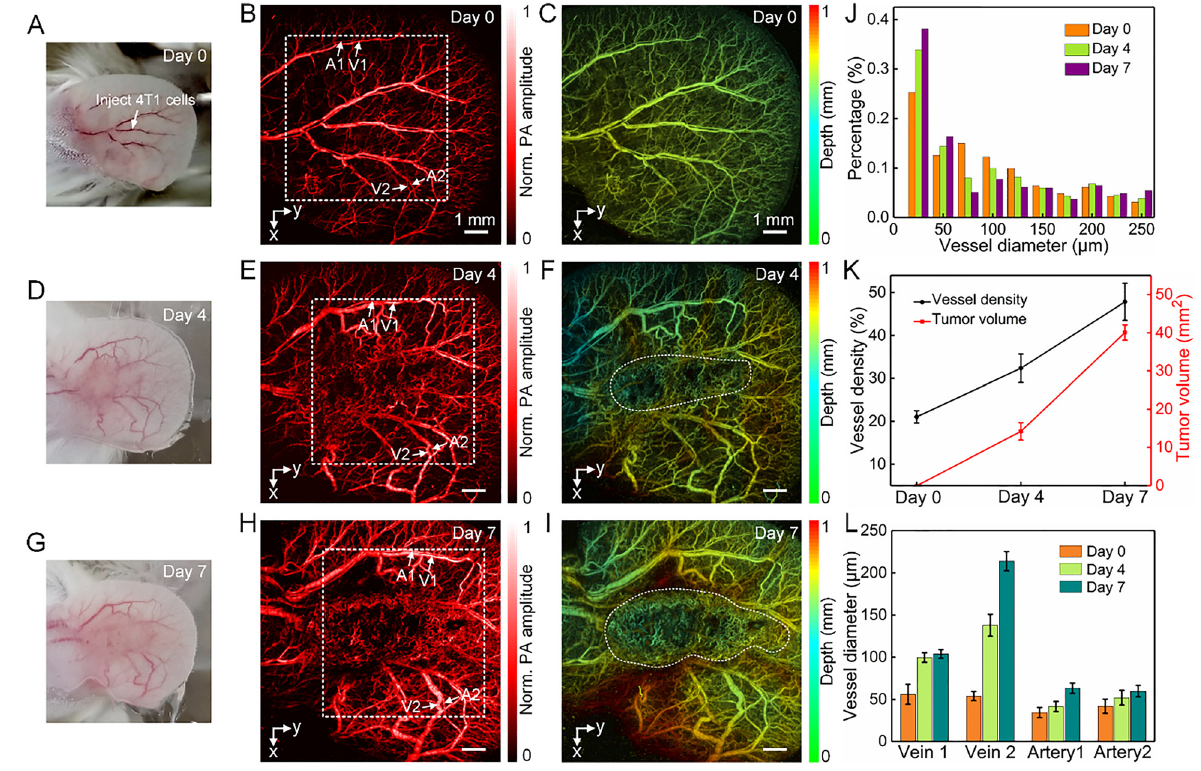
Figure 3: In vivo monitoring of the tumor growth by photoacoustic microscopy. (A)Mouseearbeforeinjecting4T1tumorcells(day0).(B)Themaximumamplitudeprojectionmicrovasculatureimageofthemouseearonday 0. The whitedotted box is theregion of interest.(C) The depth-codedmicrovasculature imageof the mouseear onday 0. (D) The mouseear on day4.(E)The maximumamplitudeprojectionmicrovasculatureimageof themouseearonday4.(F) Thedepth-codedmicrovasculatureimage ofthemouseearonday4.(G)Themouseearonday7.(H)Themaximumamplitudeprojectionmicrovasculatureimageofthemouseearonday 7.(I)Thedepth-codedmicrovasculatureimageofthemouseearonday7.(J)Thedistributionofvasculardiameteronday0,day4,day7.(J)The distributionofvasculardiameteronday0,day4,day7.(K)Thevesseldensityandtumorvolumeonday0,day4,day7.(L)Thediametersofthe arteries and veins on day 0, day 4, day